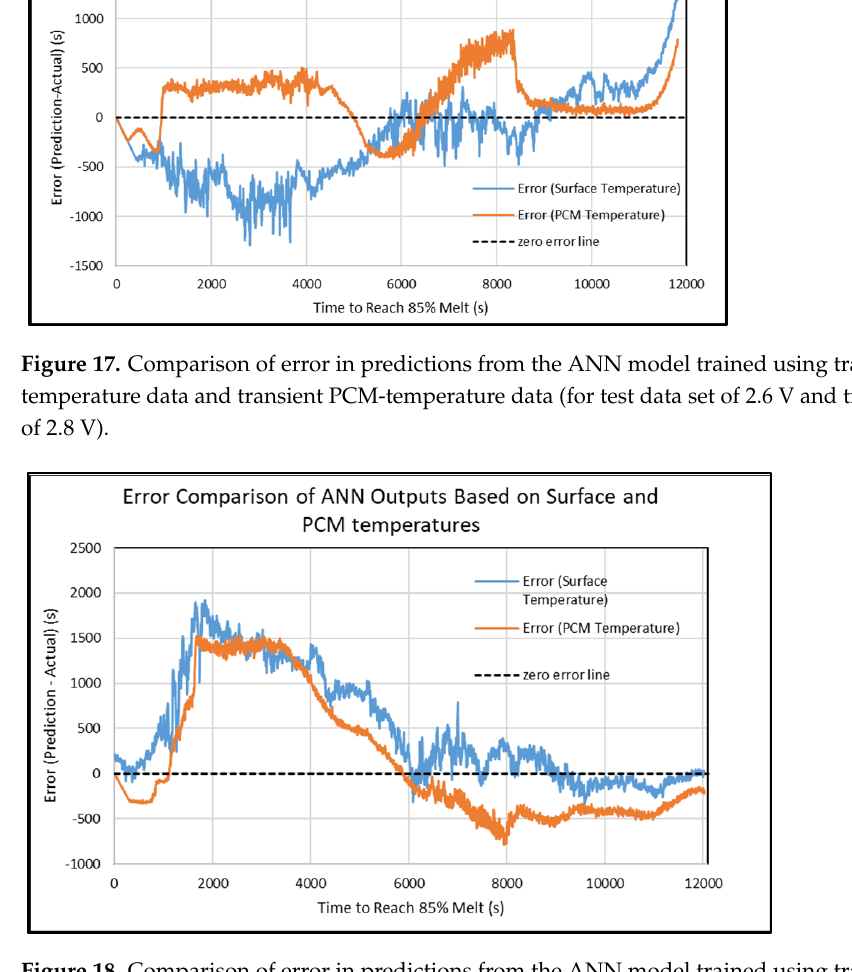
Figure 18. Comparison of error in predictions from the ANN model trained using transient surface- temperature data and transient PCM-temperature data (for test data set of 2.3 V and training data set of 2.6 V).